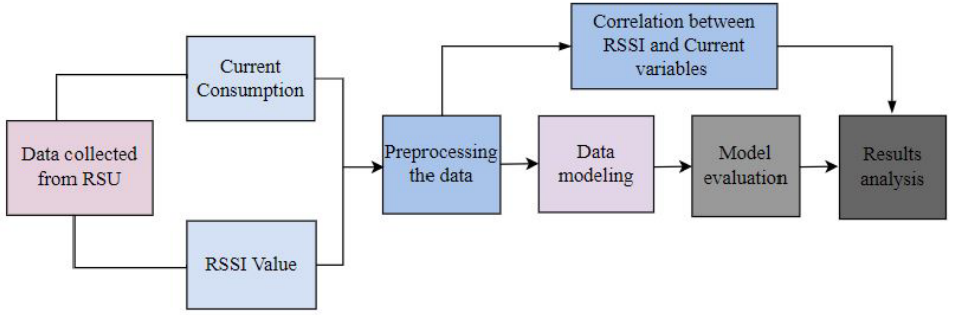
Figure 8. Data collection and